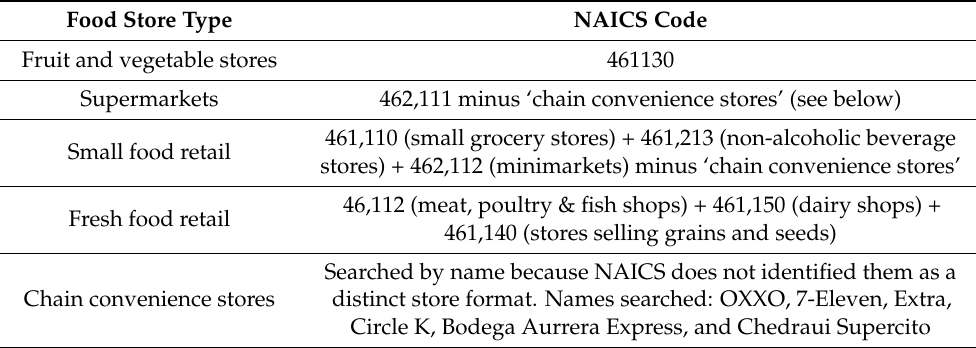
Table A1. North American Industrial Classification (NAICS) codes utilized to define food store types in the present study.